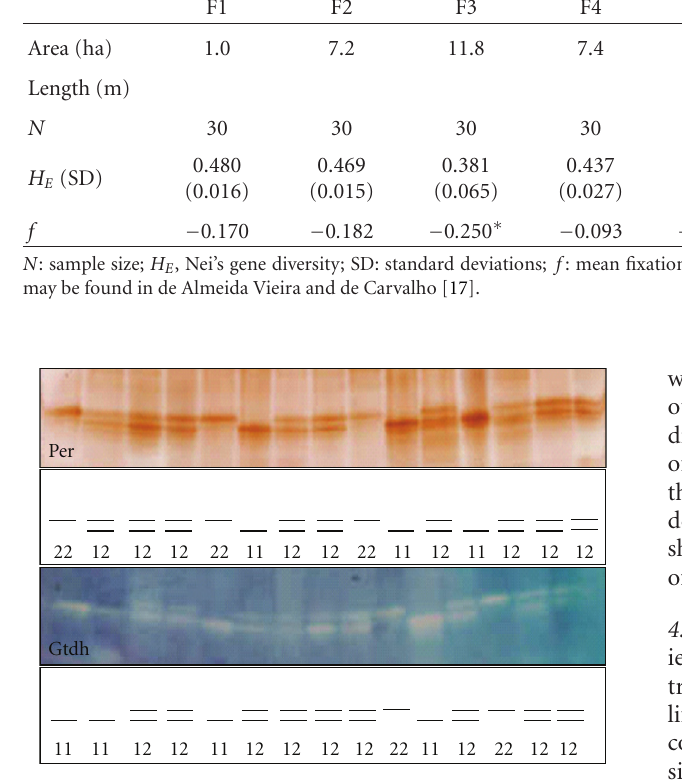
Figure 5: Zymograms of Protium spruceanum for the enzyme systems peroxidase ( Per ) and glutamate dehydrogenase ( Gtdh ) with schematic illustrations and genotype